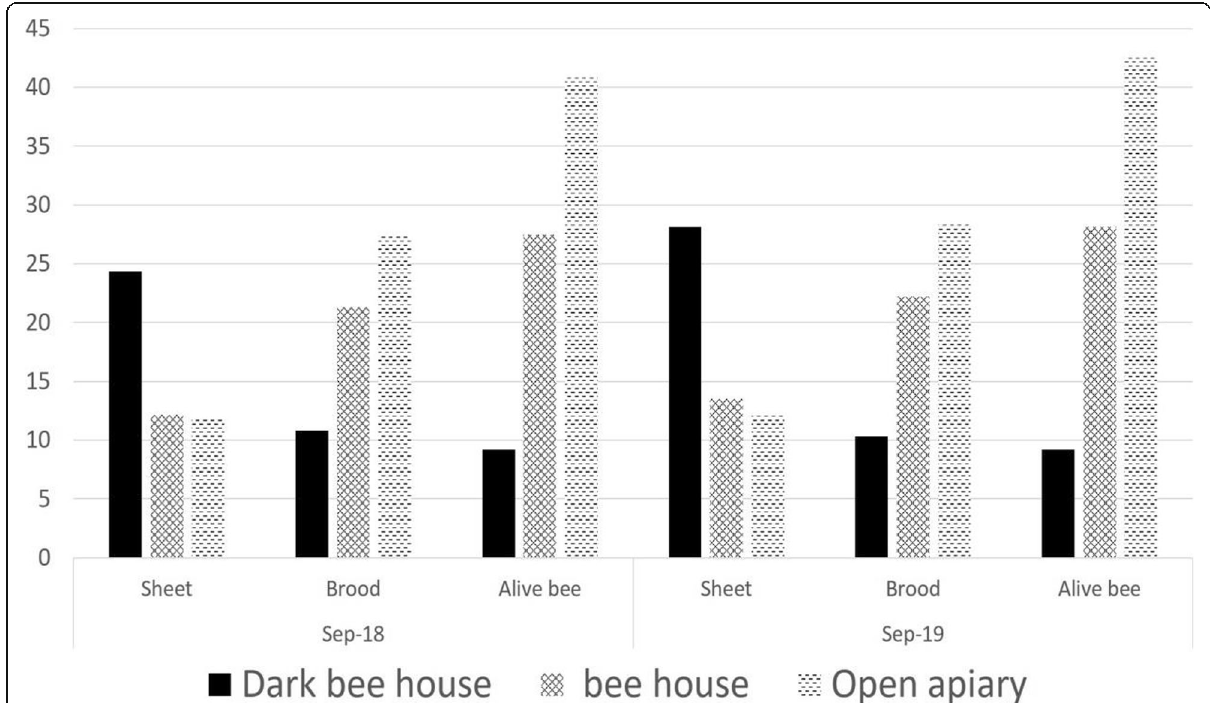
Fig. 2 Effect of keeping-bee hives in a dark bee house compared with keeping them in a normal bee house that has windows and in open apiary on the average number of fallen Varroa mites on white card board sheets (coated with Vaseline) as well as found on broods and alive bees, during September of 2018 and 2019 at Dakahlia governorate